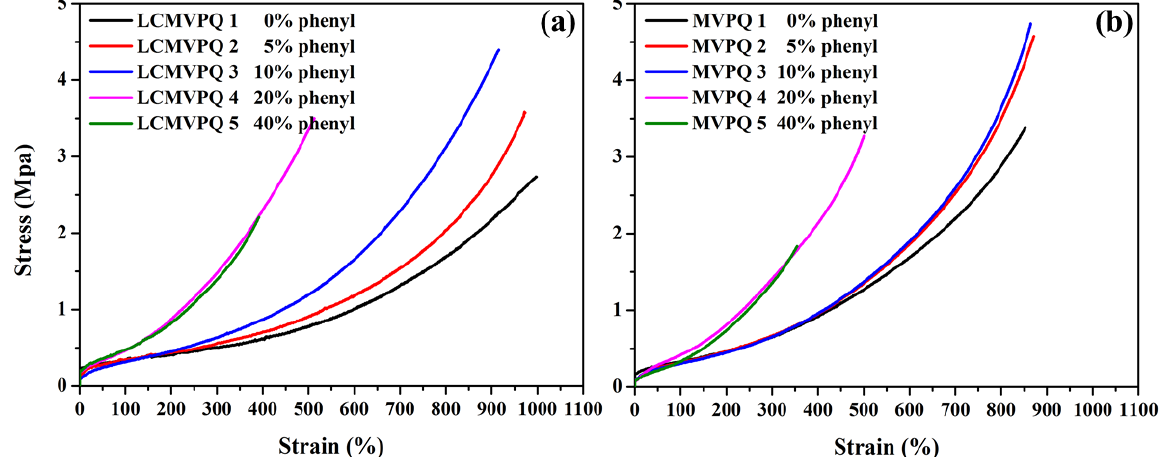
Figure 5. Stress-strain curves of ( a ) LCMVPQ 1 – 5 and ( b ) MVPQ 1 – 5. The curves were performed at 25 °C. Table 5. Summary of the tensile strength and elongation at break.